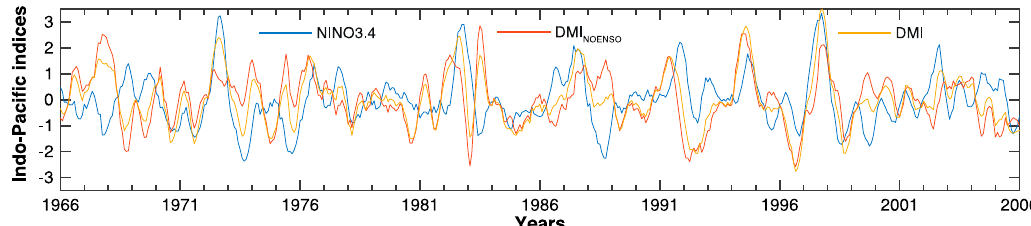
Figure 2. Normalized monthly time series of NINO3.4 sea surface temperature anomaly (SSTA), the original Dipole Mode Index (DMI), and the new El Niño southern oscillation (ENSO)-independent DMI (DMI NOENSO ) for the period 1966–2006.